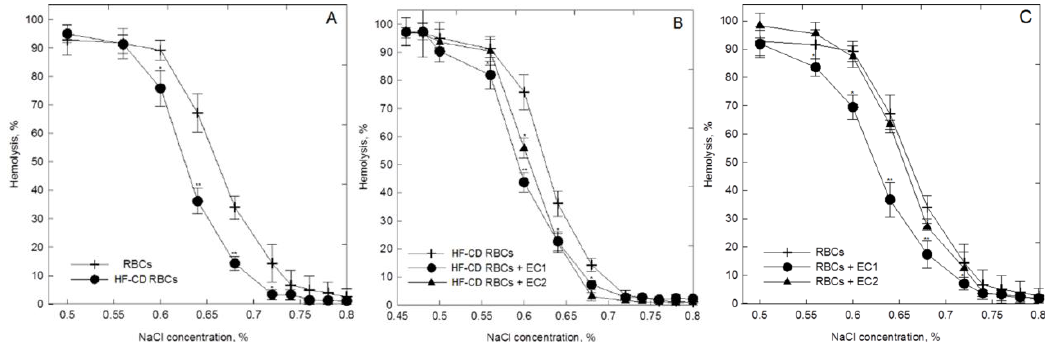
Figure 3. Percentage of hemolysis of control erythrocytes (RBCs) and these modified by 0.05 mg/mL of extracts form Cistus incanus L. (EC1 and EC2) in hypotonic and isotonic solutions of sodium chloride Panel A, B, C. The RBCs were obtained from healthy pig and pig fed a high fat-carbohydrates diet (HF-CD).